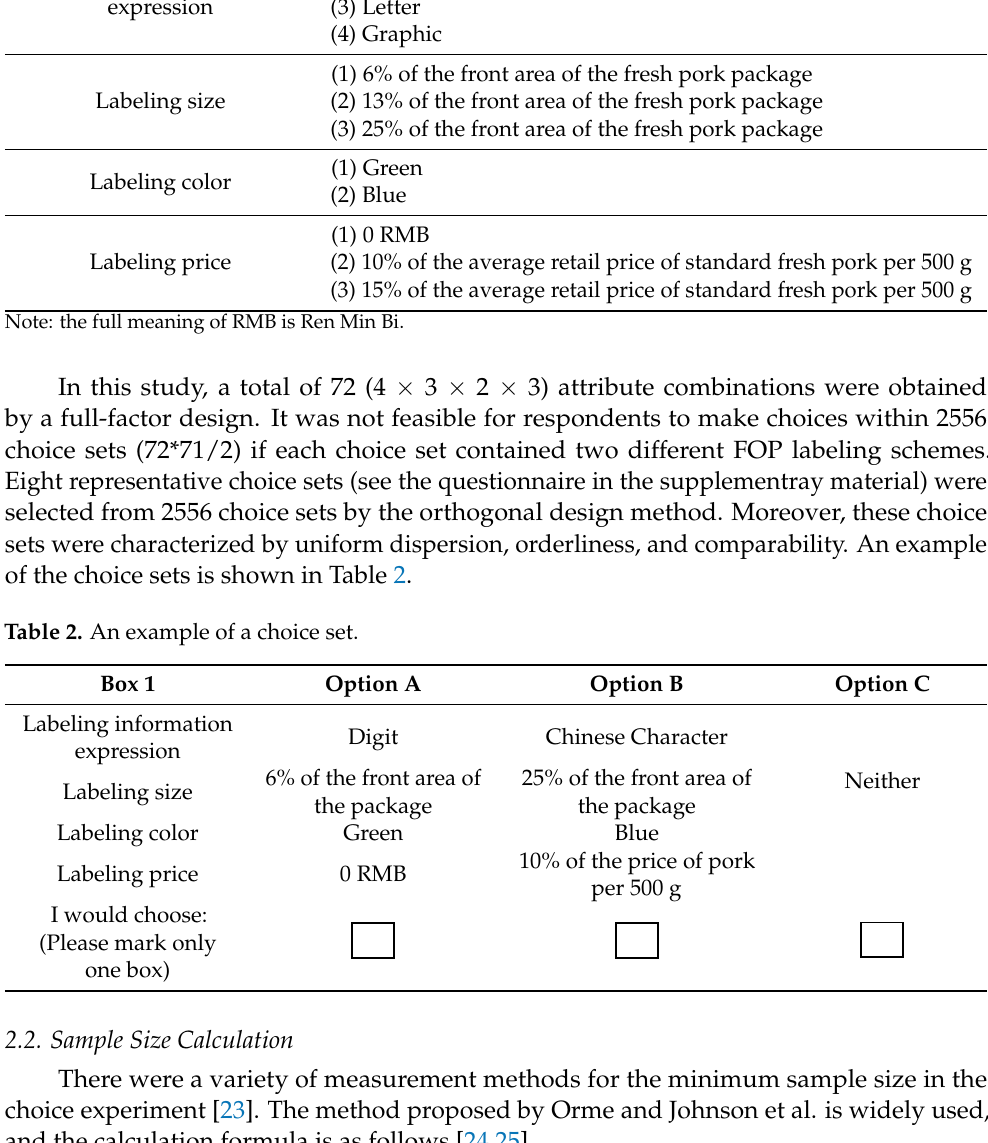
Table 1. Attributes and levels set in the choice.